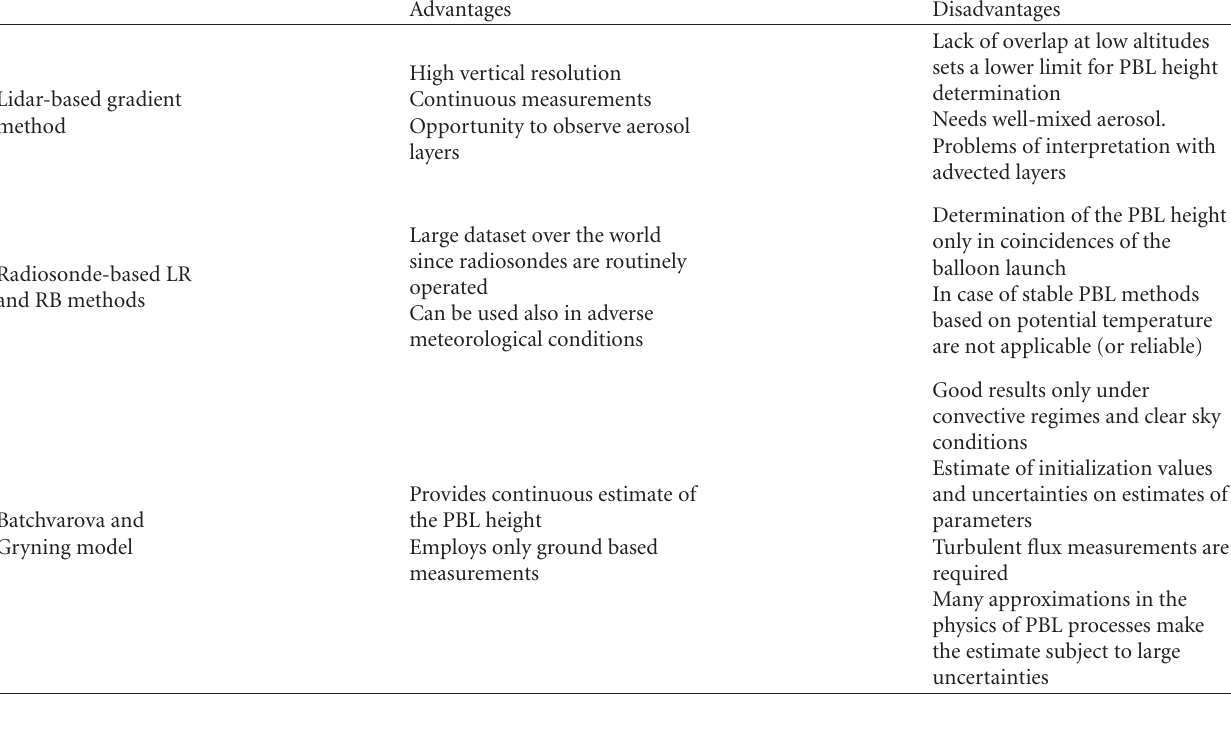
Table 1: Comparison between the advantages and drawbacks of the three approaches to determinate the PBL height.